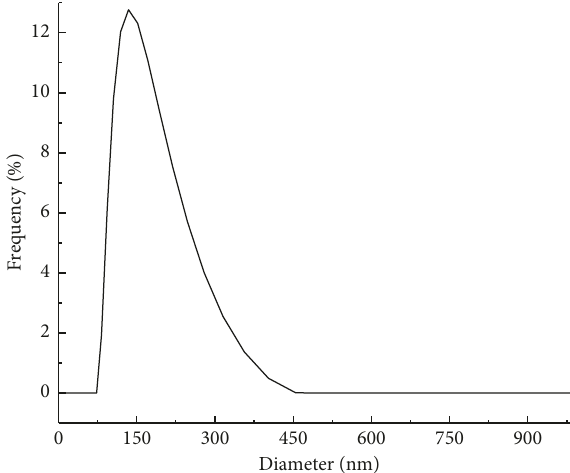
Figure 9: Granularity diagram of SPS nanoparticles.